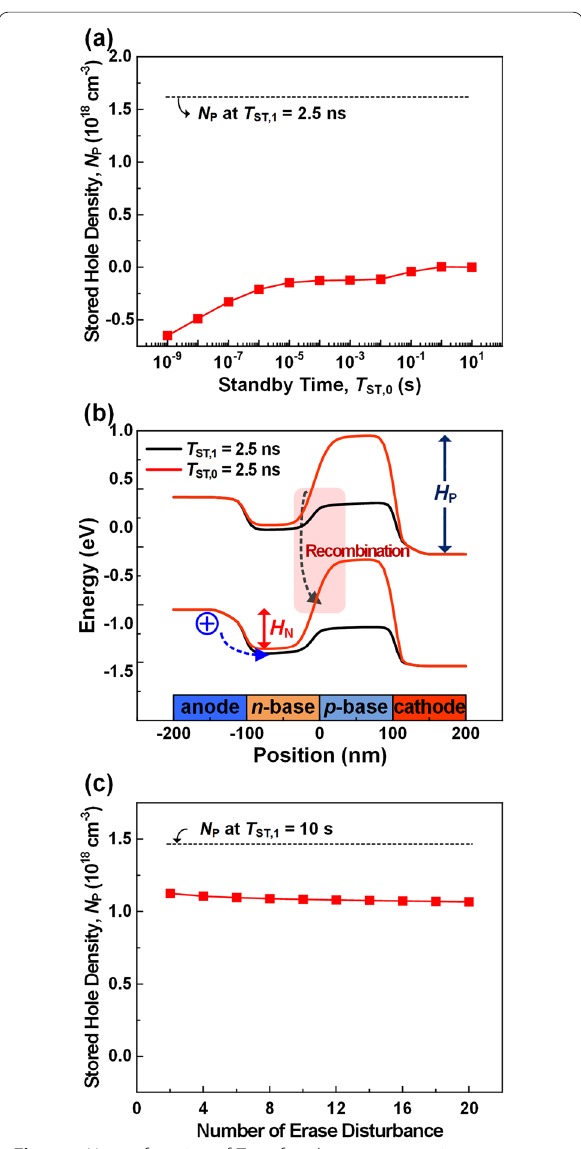
Fig. 7 a N P as a function of T ST,0 after the erase operation at T ST,1 2.5 ns. b Energy band diagrams at T ST,1 = T ST,0 2.5 ns. c N P as a function of the number of the erase = disturbance pulse